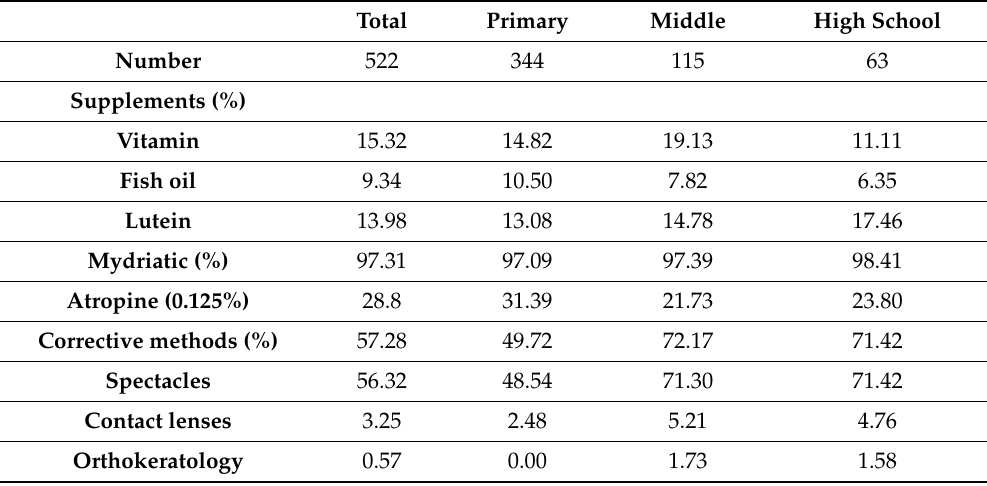
Table 2. Intake of food supplements for eye care and treatment for